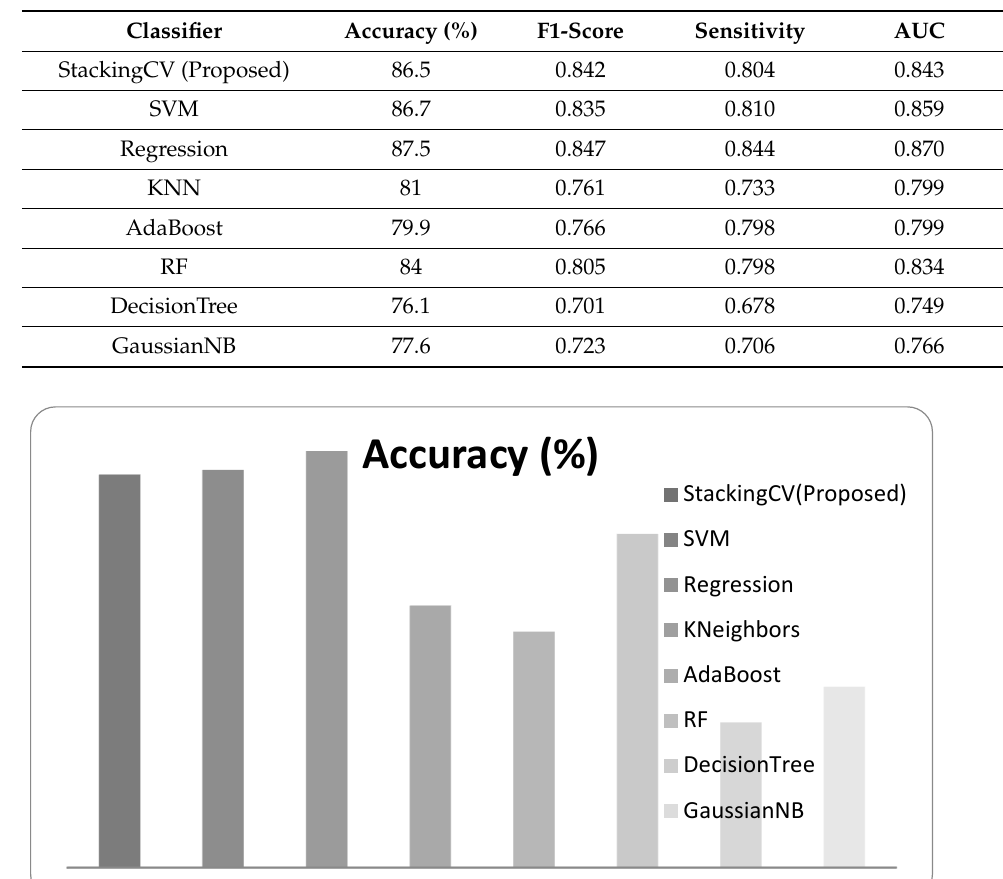
Figure 11. Performance of the system for VGG16 features.